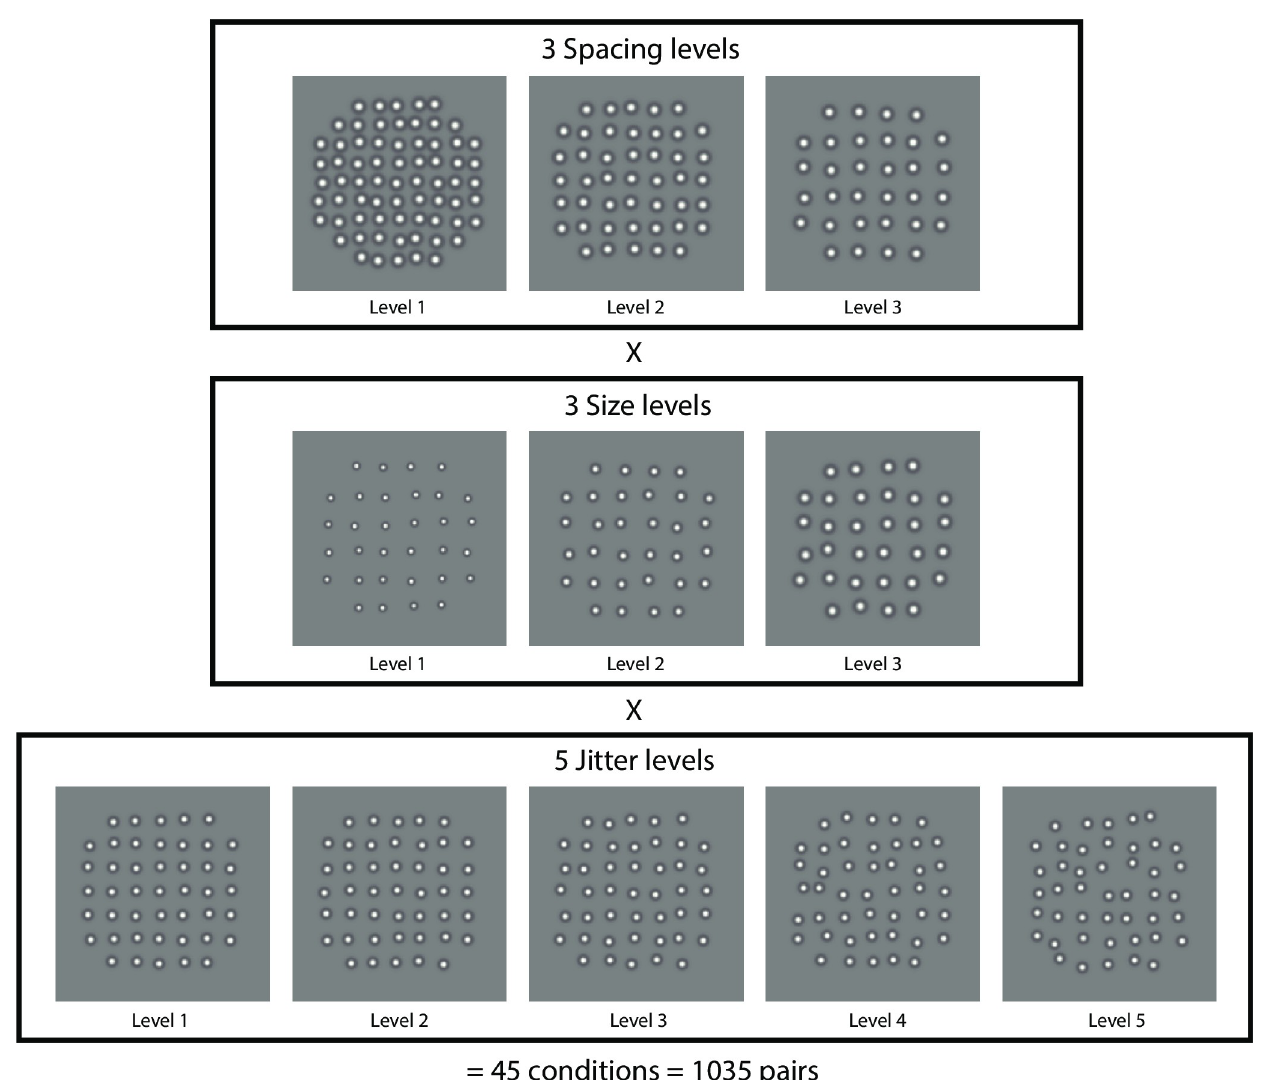
Fig 1. Example stimulus texture patterns in the experimental design. Textures were composed from DoG (Difference of Gaussian) micropatterns. Each stimulus texture was assigned one of three element spacing levels (top row), one of three element size levels (middle row), and one of five element jitter levels (bottom row), for a total 3 × 3 × 5 = 45 conditions, and 1035 possible combinations of pairs ((44 × 45)/2 + 45) = 1035), including 45 same-condition pairs. Examples of 11 out of 45 conditions are depicted here. In the top row of stimuli, spacing level is 1 to 3 from left to right (small to large) at size level 3 and jitter level 2. In the middle row, both spacing level and jitter level are 3, and size level is 1 to 3 from left to right (small to large). In the bottom row, both spacing level and jitter level are 2, and jitter level is 1 to 5 from left to right (more regular to more irregular).